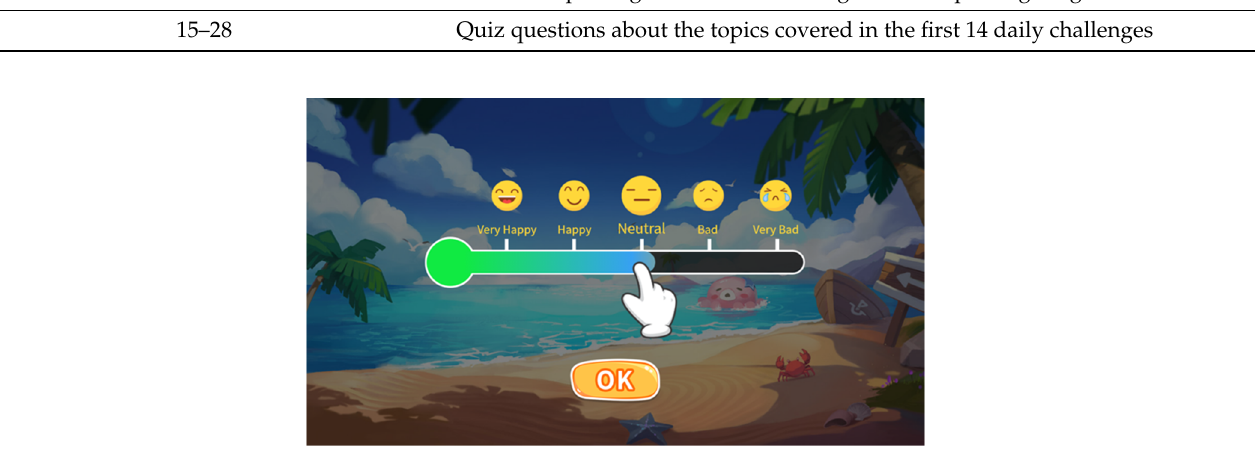
Figure 1. Screenshot of daily challenges within CareMom.